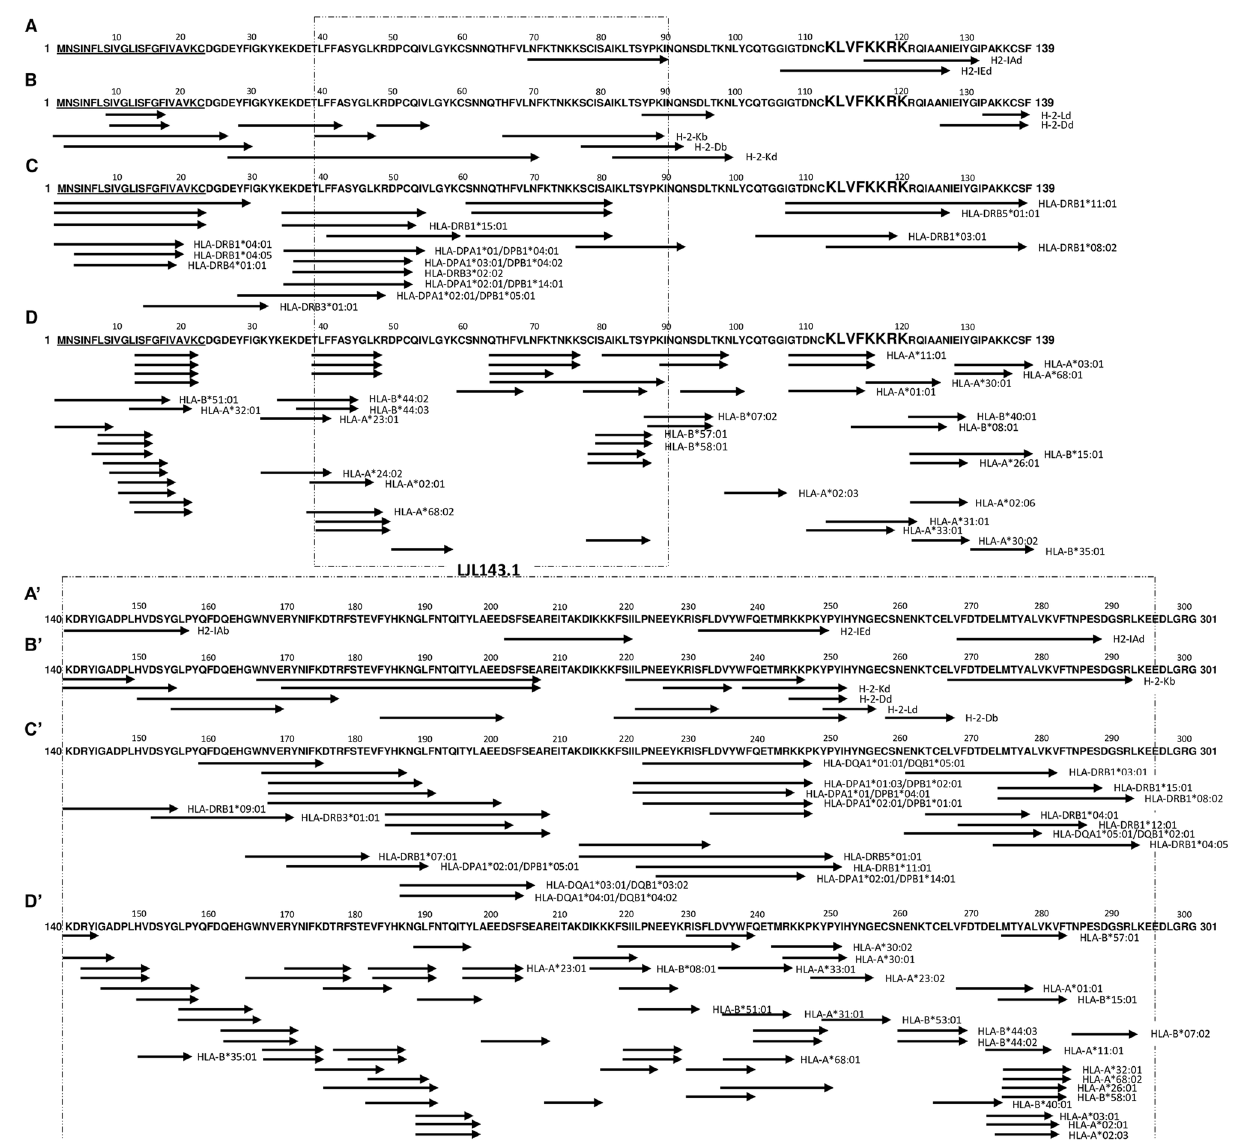
Figure 2. LJL-143T cell epitope mapping: overall picture of the in silico analysis performed against murine and human MHC-I and MHC-II molecules. LJL-143 (GenBank acc. No. AAS05319) T cell epitope mapping was performed using the IEDB Analysis Resource considering 3 murine and 27 human MHC-II alleles and 5 murine and 27 human MHC-I alleles. The translated results of the predictions of murine MHC-II restricted epitopes ( A,A ′ ), murine MHC-I restricted epitopes ( B , B ′ ), human MHC-II restricted epitopes ( C , C ′ ) and human MHC-I restricted epitopes ( D , D ′ ) are represented. Results are presented by allele. Each arrow represents one or more (contiguous) predicted epitopes: the top 1% hits for MHC-I molecules and the top 2.5% (very high affinity binders) or 10% hits for MHC-II human and murine alleles, respectively. The underlined protein residues represent the signal peptide sequence. The magnified protein residues are potentially important for protein biological activity. Dashed boxes represent the convergent analysis of the different in silico determinations that enabled the selection of two protein portions to be included in the final chimeric sandfly salivary